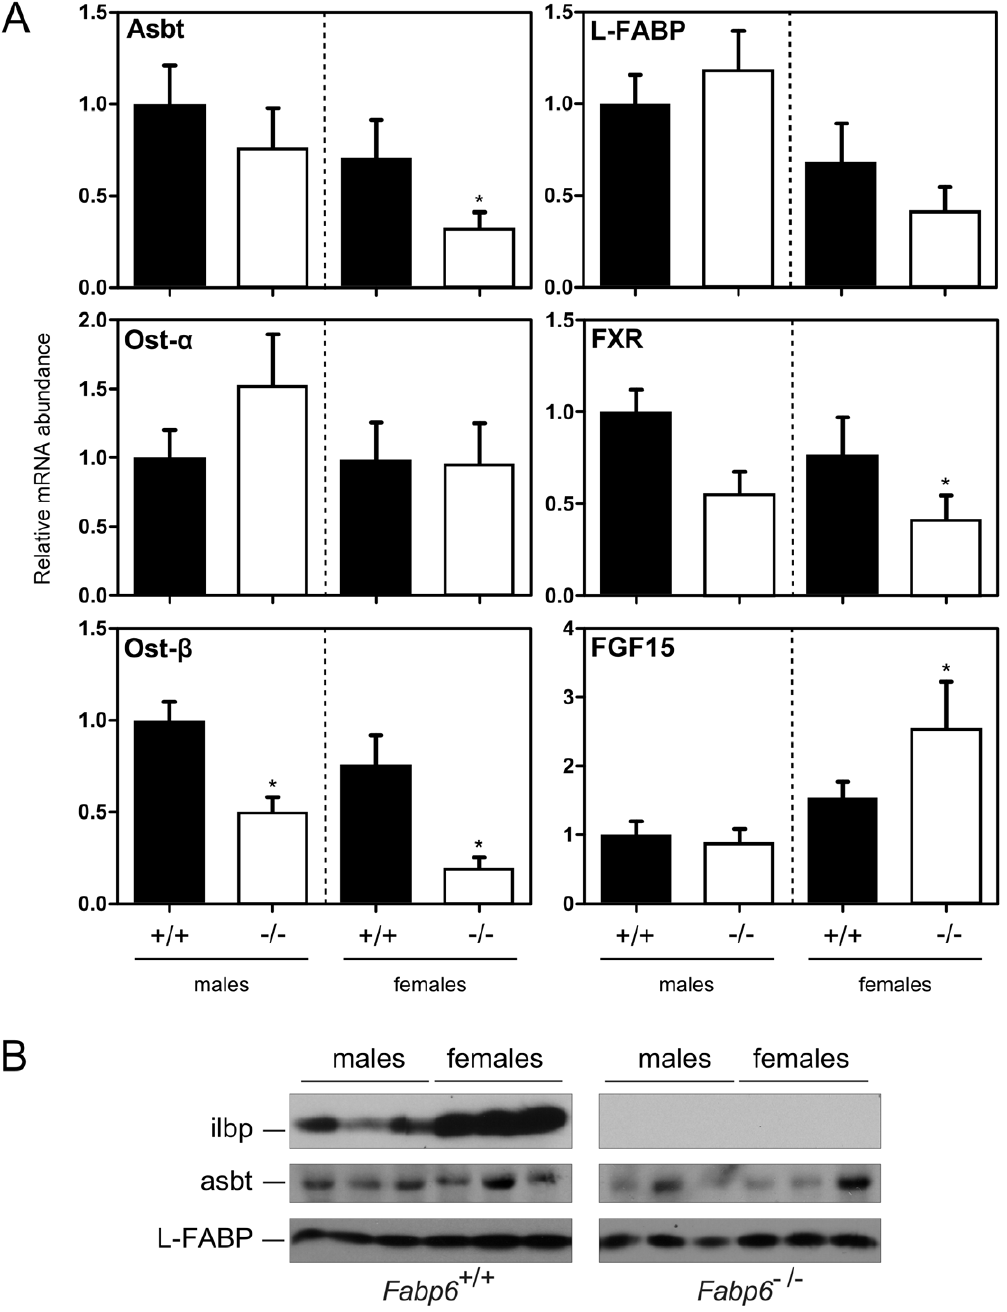
Figure 6. Survey of gene expression in the small intestine. (A) qPCR analysis of RNA from small intestines of Fabp6 + / + (black bars) and Fabp6 2 / 2 (white bars) were done in duplicates. The normalized abundance (mean 6 SEM) of target mRNAs is expressed relative to male Fabp6 + / + mice. P , 0.05, vs. wild-type of the same sex. (B) Protein blots of small intestine homogenates of Fabp6 + / + and Fabp6 2 / 2 mice were probed with antisera to ilbp, asbt and